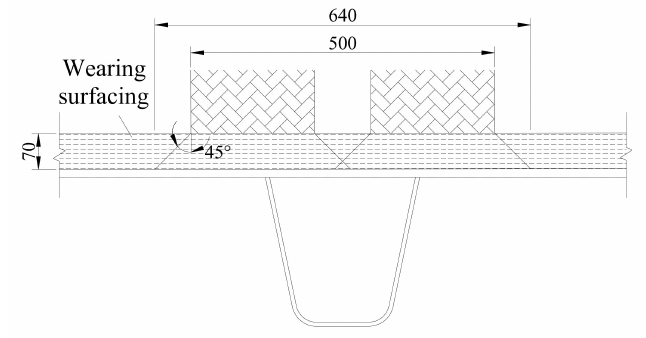
Figure 10. Tire dispersal width in bridge transverse direction. (Unit: mm).